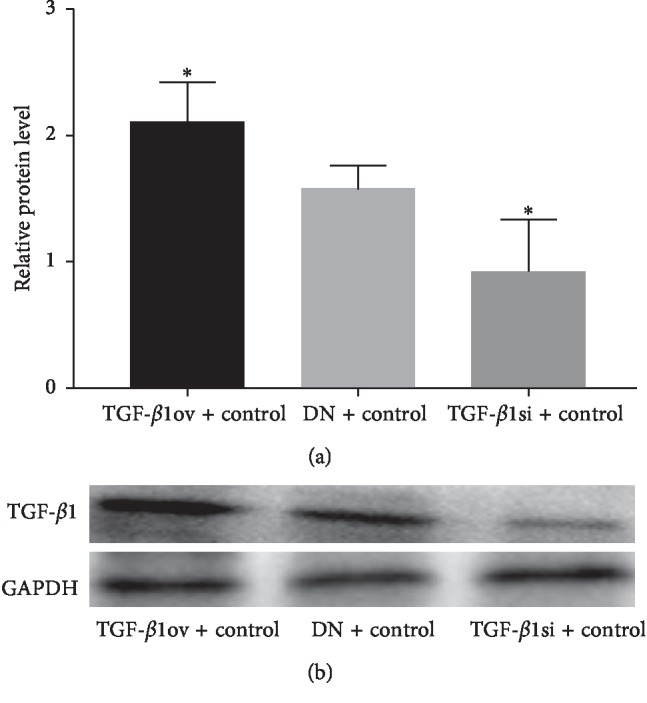
Protein expression of TGF-β1. (a) Relative protein. (b) Western blotting. TGF-β1ov + control, TGF-β1 overexpression + oil; TGF-β1si + control, TGF-β1 siRNA + oil; DN + control, DN + oil. ∗p < 0.05 vs DN + control.